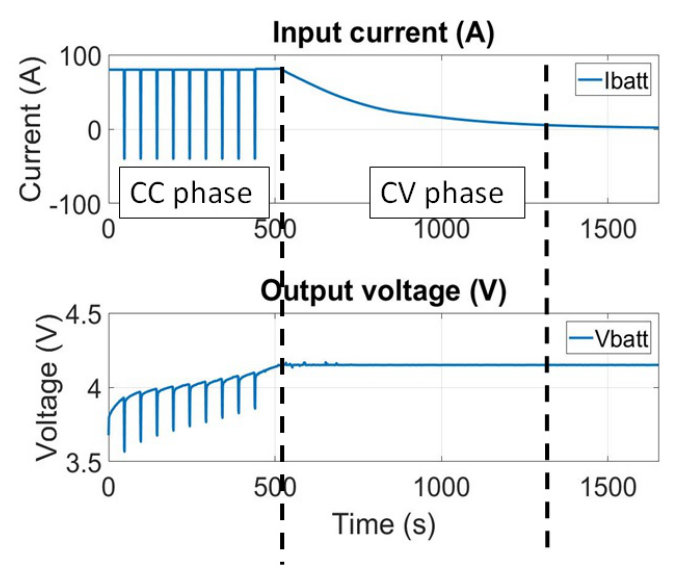
Figure 6. Applied CCNP profiles and voltage response of the NMC/C